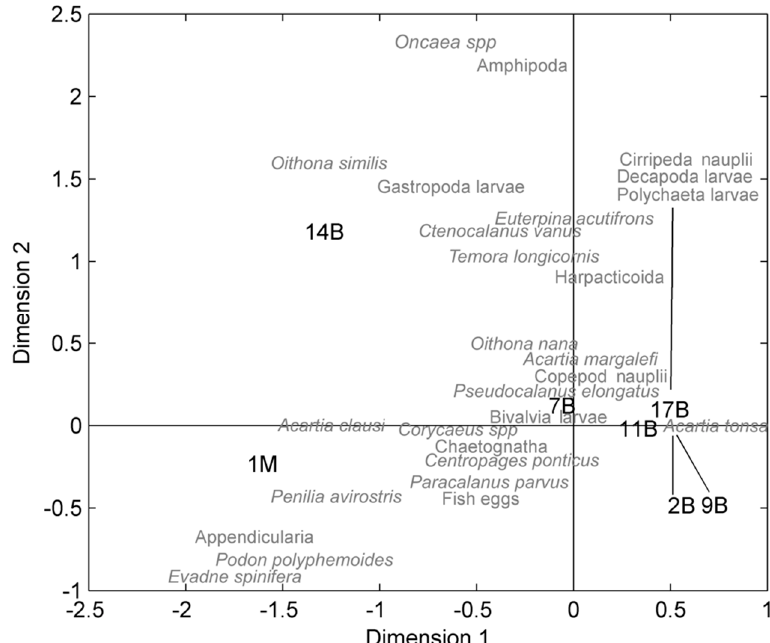
Figure 6. Results of the correspondence analysis (CA) performed on seven stations and total annual abundances (May 2003–April 2004). The first letter of each species’ name corresponds to the actual position on the CA space. For enhanced readability, only species with relative abundance >5‰ are shown. Stations B2 and B9 as well as Polychaeta larvae, Decapoda larvae, and Cirripeda nauplii species have been moved from their respective original positions, indicated by the black lines.